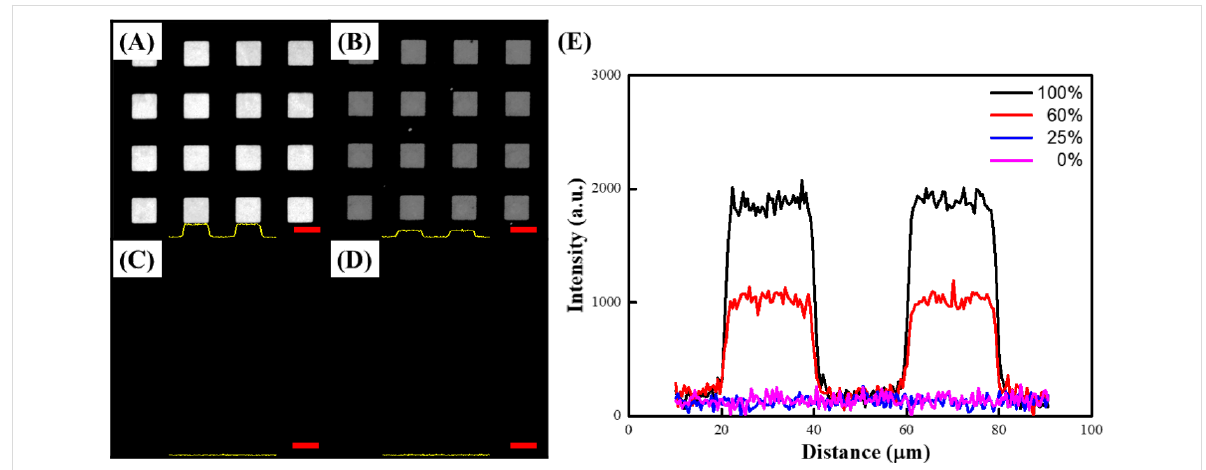
Figure 3: Fluorescence images (A–D) and intensity profiles (E) of FAM-labelled DNA-patterned surfaces fabricated by CLL for (A) 100% MCU SAM (0% UT), (B) 60% MCU SAM (40% UT), (C) 25% MCU SAM (75% UT), and (D) 0% MCU SAM (100% UT). The scale bars are 20 μ m.